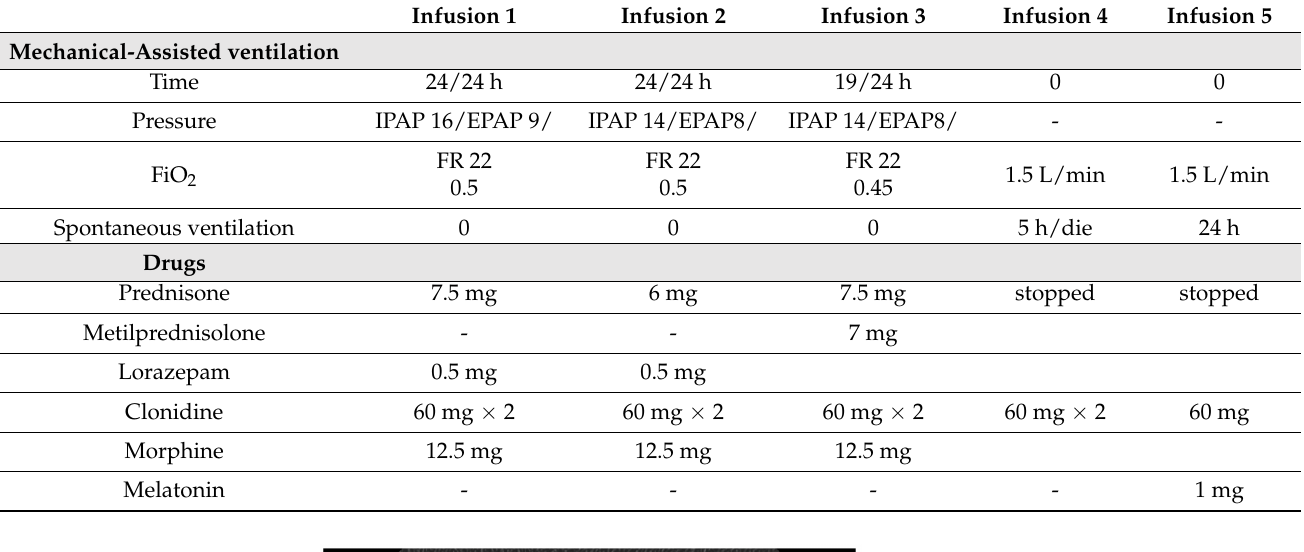
Table 3. Patient’s respiratory parameters and therapies before each MSC infusion.